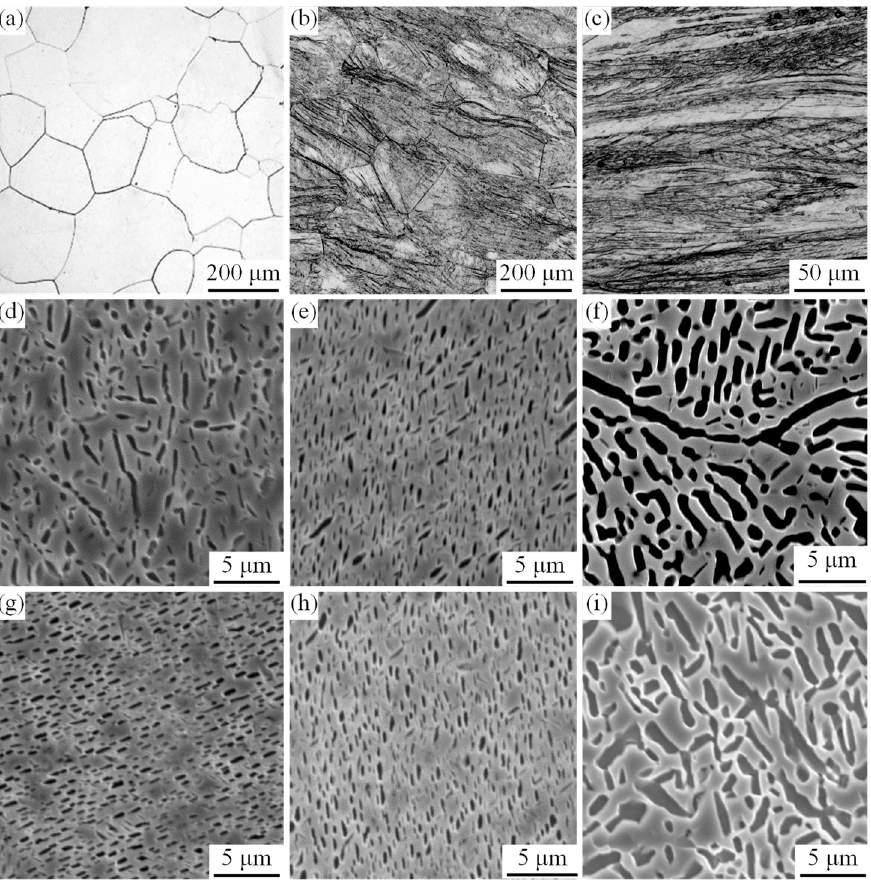
Figure 2. Microstructures of the alloys: ( a ) 2Zr-1.2O alloy after solution treatment; ( b , c ) 2Zr-1.2O alloy after cold compression, the observed plane is vertical ( b ) and parallel ( c ) to the compression direction; ( d ) 2Zr-4O alloy; ( e ) 2Zr-6O alloy; ( f ) 2Zr-10O alloy; ( g ) 0Zr-4O alloy; ( h ) 0Zr-6O alloy; ( i ) 0Zr-10O alloy.